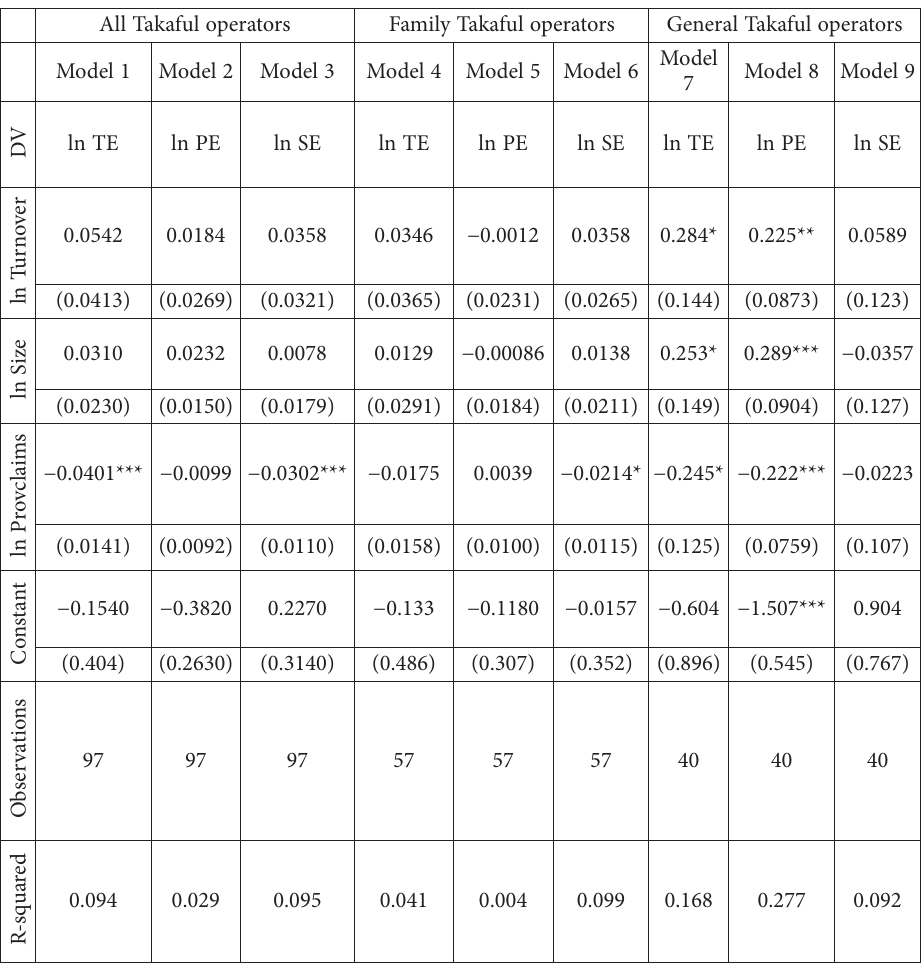
Table 4. Panel regressions of factors that impact